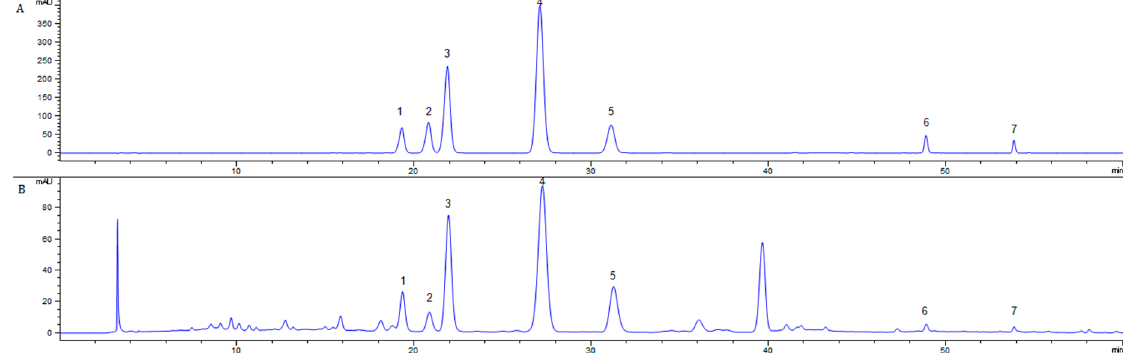
Figure 3. HPLC chromatograms of standard mixture ( A ) and extracts by DES-MAE in Ribes mandshuricum leaves ( B ) for (1) Rutin, (2) Hyperoside, (3) Isoquercetin, (4) Trifolin, (5) Astragalin, (6) Quercetin, and (7) Kaempferol.